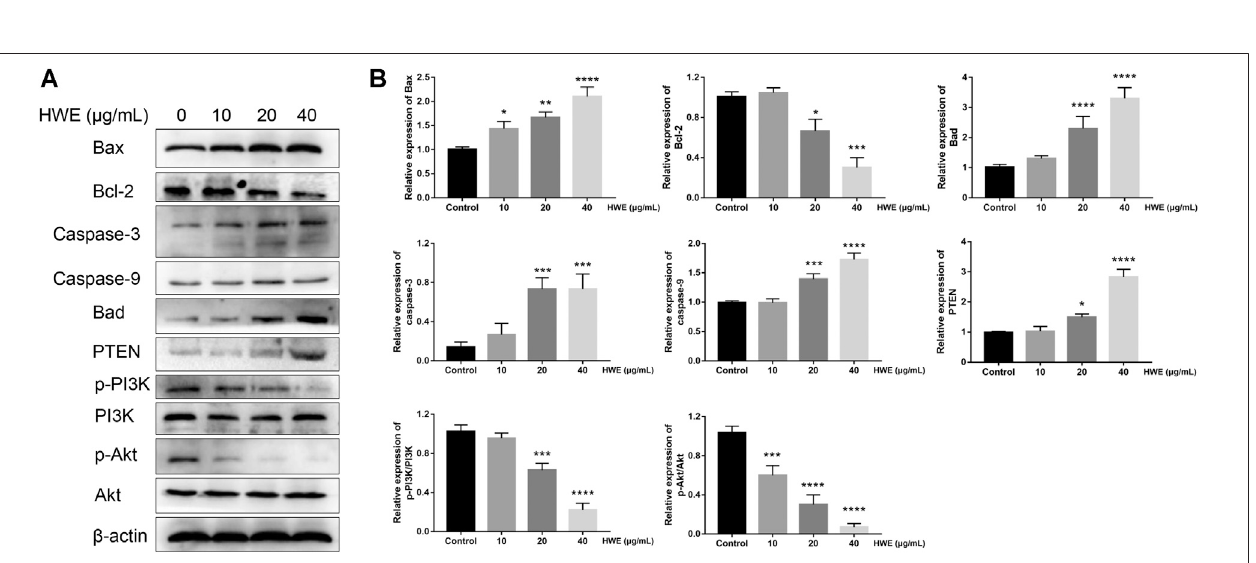
FIGURE 8 | EffectofHWEontheexpressionsofmitochondrialapoptosisandPI3Kpathway-relatedproteins. (A) MitochondrialapoptosisandPI3Kpathway-relatedproteins in HepG2 cells with or without HWE treated. (B) Quantitative analysis. The error bars represent the SD. * p < 0.05, ** p < 0.01, *** p < 0.001 and ****p < 0.0001 vs control group.